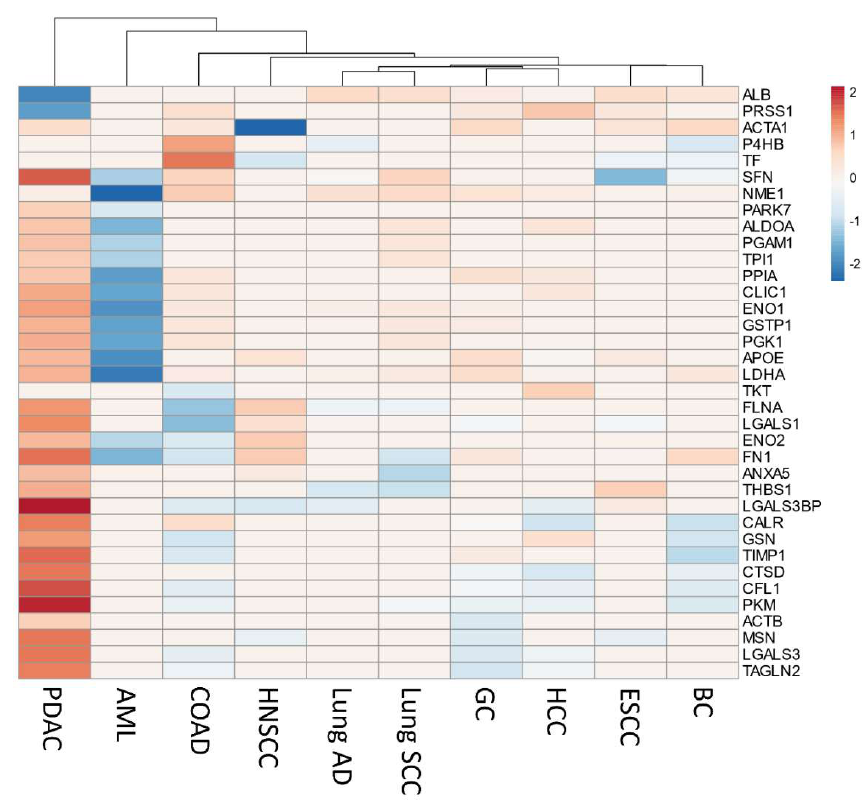
Figure 5. The upregulation of secretome genes is strongly associated with pancreatic ductal adenocarcinoma (PDAC). Heatmap of expression levels of genes [log2 (TPM + 1)] encoding 39 secreted proteins identified as secreted in PDAC, in 10 different tumor types from TCGA compared to their respective normal tissues. Genes that are specifically upregulated or downregulated genes in each tumor type (absolute values of fold-change > 1.0 and q -value < 0.01; ANOVA) are shown in red and blue, respectively. Both columns (tumor types) and rows (secretome genes) were clustered using Euclidian distance. Three genes ( ARHGDIA , AHSG , and EEF1A1 ) presented missing values in 90%– 100% of the tumor types and are not represented in the heatmap (constant rows were removed during data pre-processing). The differential expression levels from tumor tissue versus combined normal TCGA and GTEx data were calculated using the web-based Gene Expression Profiling Analysis tool (GEPIA) [105]. GC: Gastric carcinoma; COAD: Colon adenocarcinoma; HCC: Hepatocellular carcinoma; Lung SCC: Lung squamous cell carcinoma; BC: Breast carcinoma; HNSCC: Head and neck squamous cell carcinoma; ESCC: Esophageal squamous cell carcinoma; Lung AD: Lung adenocarcinoma; AML: Acute myeloid leukemia.